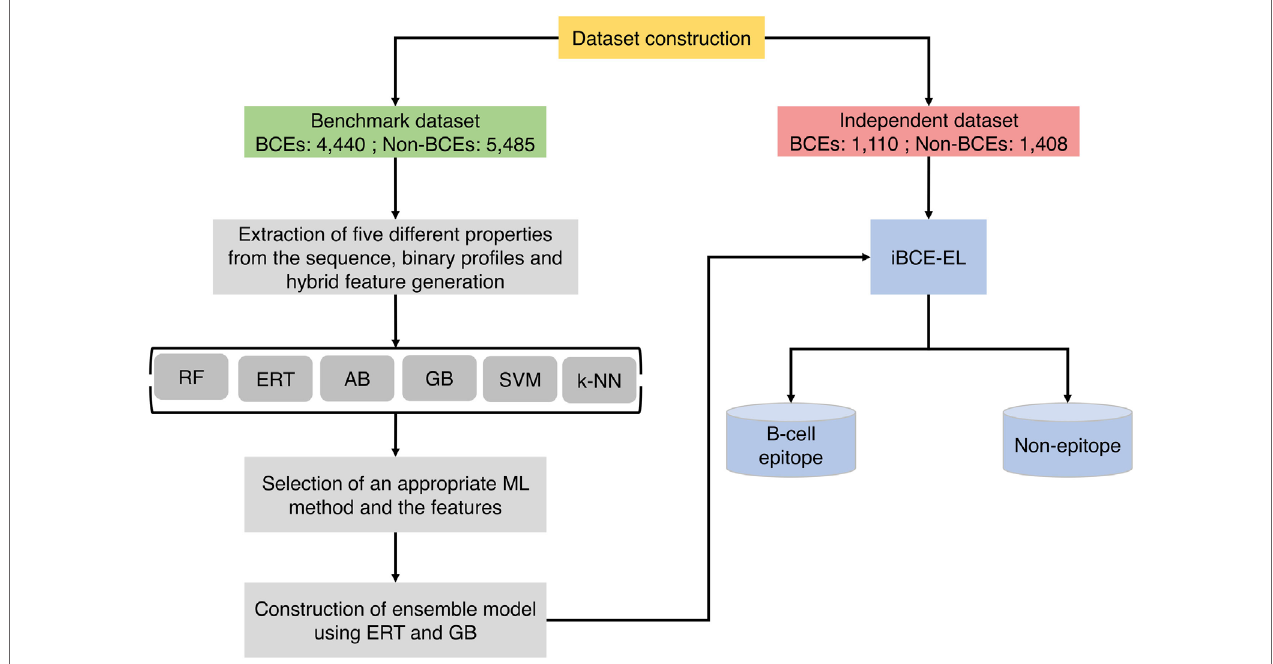
FIGURe 1 | Overall framework of the proposed predictor. iBCE-EL development involved the following steps: (1) dataset curation, (2) feature extraction, (3) exploration of six different ML algorithms and selection of an appropriate algorithm and the corresponding features, and (4) construction of ensemble model.